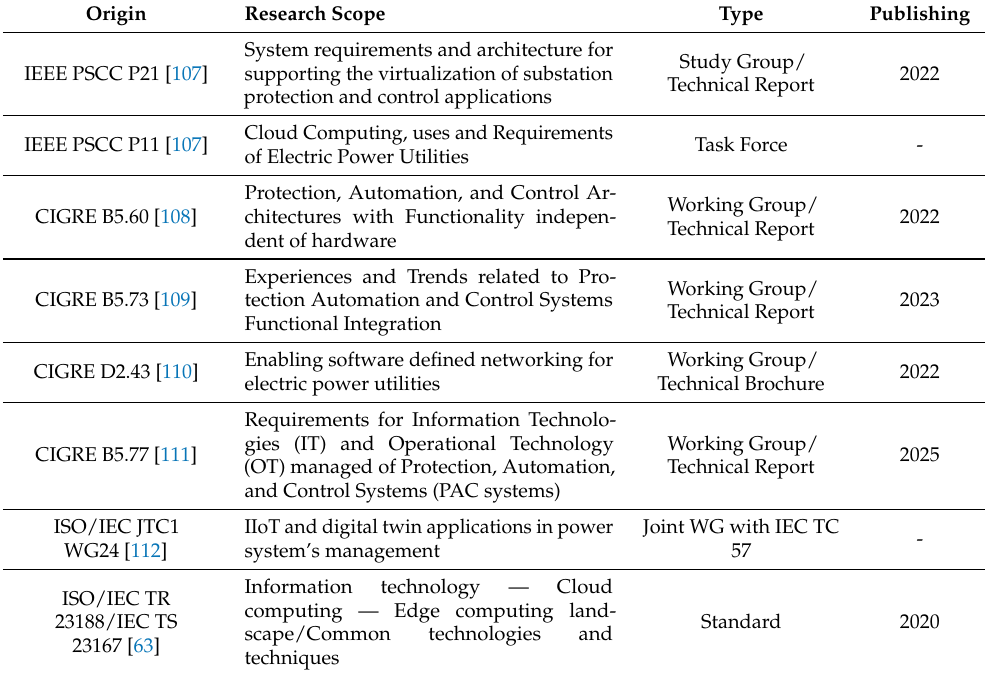
Table 5. Standards Groups in relation with virtualized PAC